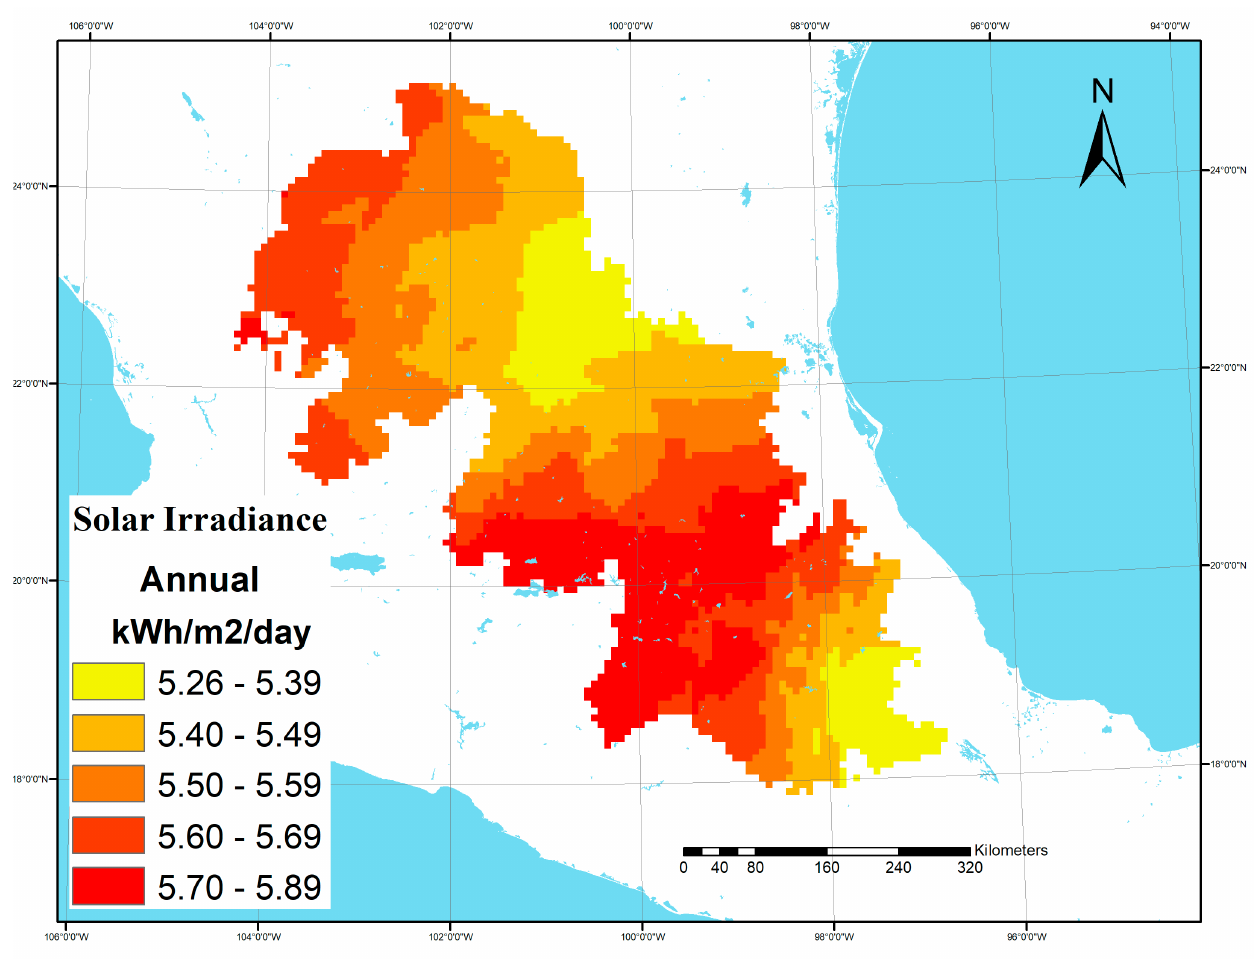
Figure 13. Annual average solar irradiation.